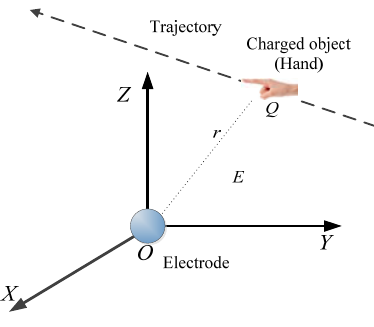
Figure 1. Schematic of the spherical electrode.